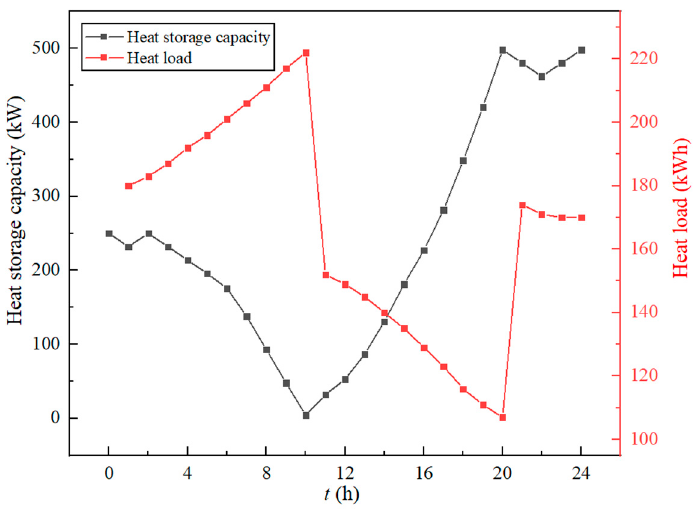
Figure 13. Heat storage capacity and heating load in each period when the objective function is geothermal energy utilization coefficient.